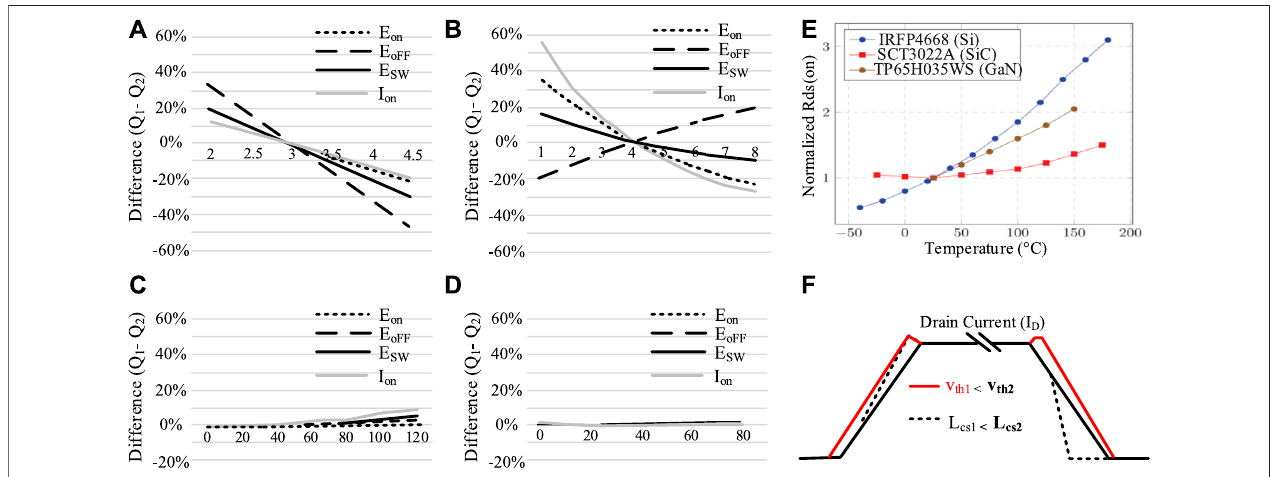
FIGURE5| Effectofparametersdiscrepancyonthedifferenceofswitchinglossesbetweenparallel-connectedSiCMOSFETs(Timms,2018) (A) Variationin Vth (B) Variation in L s (C) Variation in L g (D) Variation in L d (E) Temperature impact on R DSon of Si, SiC and GaN in TO-247 package (Yadav and Nag, 2021) (F) In fl uence of Vth and L s on drain current (Timms, 2018).